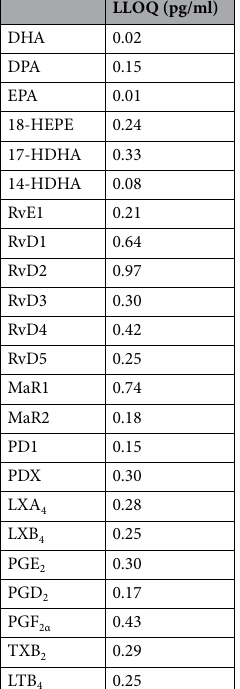
Table 4. Lower limits of quantification. The LLOQ was defined as the analyte concentration with a signal/ noise ≥ fivefold the signal/noise of the blank solution. Abbreviations: docosahexaenoic acid